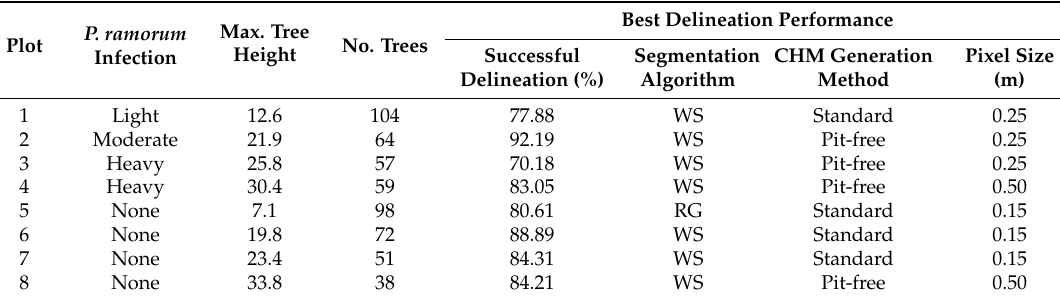
Table 8. Best performing segmentation algorithm, CHM generation method and pixel size for the tree crown segmentation in each of the sample